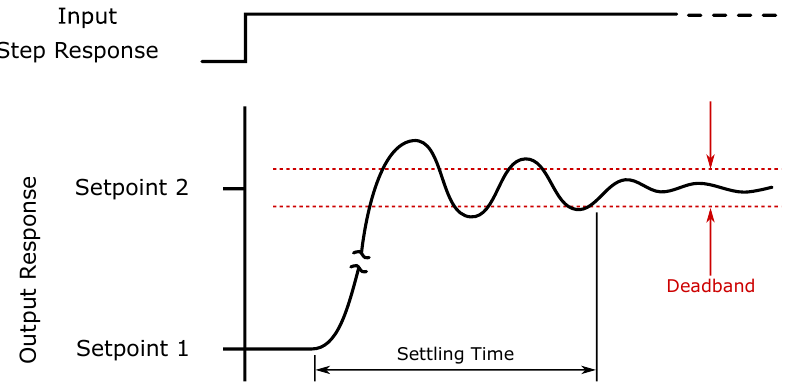
Figure 2. Step response.